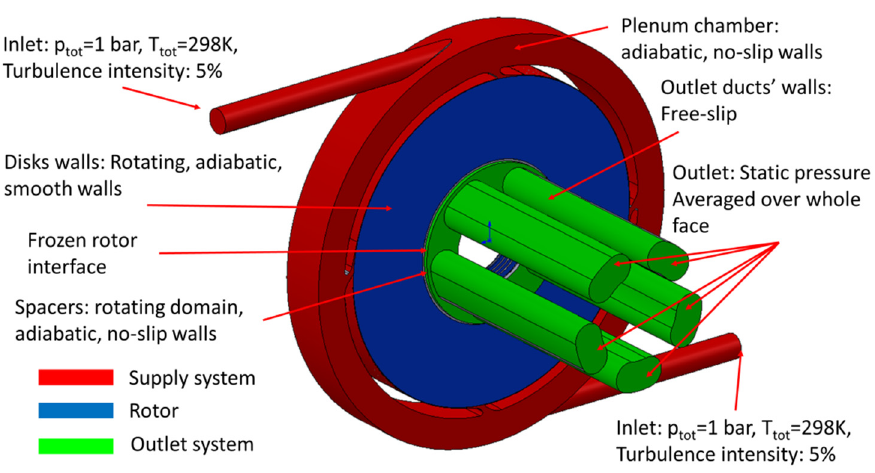
Figure 6. Details of boundary conditions.